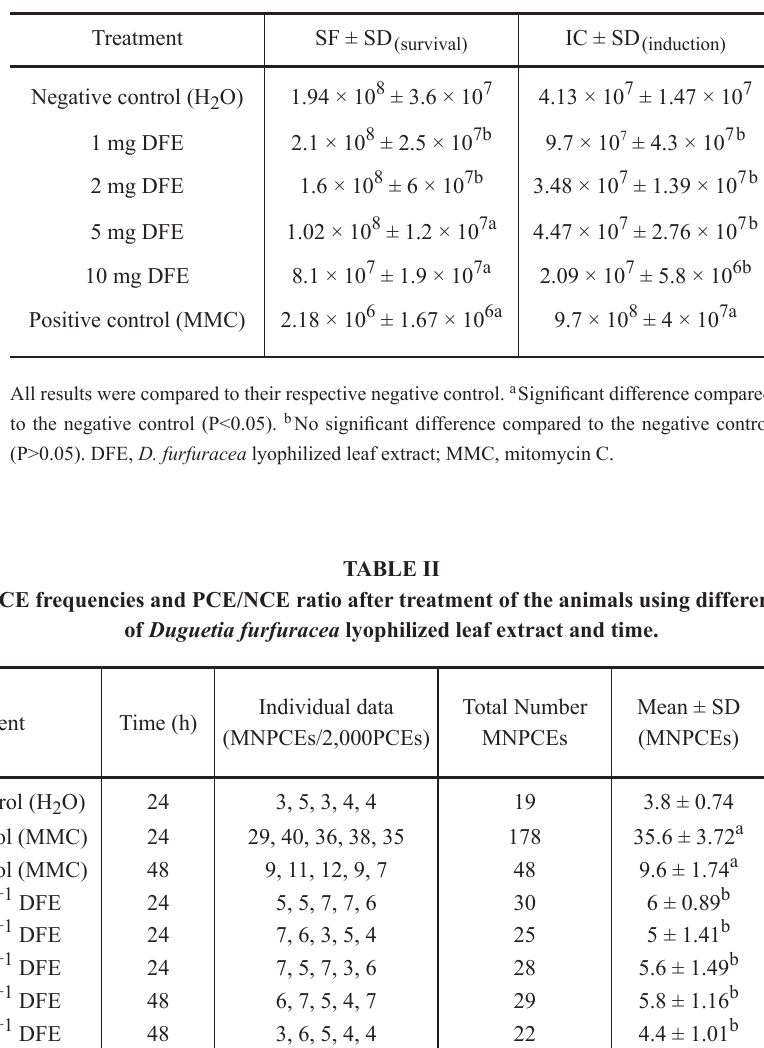
Survival fraction (SF) and standard deviation (SD) of number of colonies of E. coli WP2s(λ), infective centers (IC) and standard deviation (SD) in RJF013